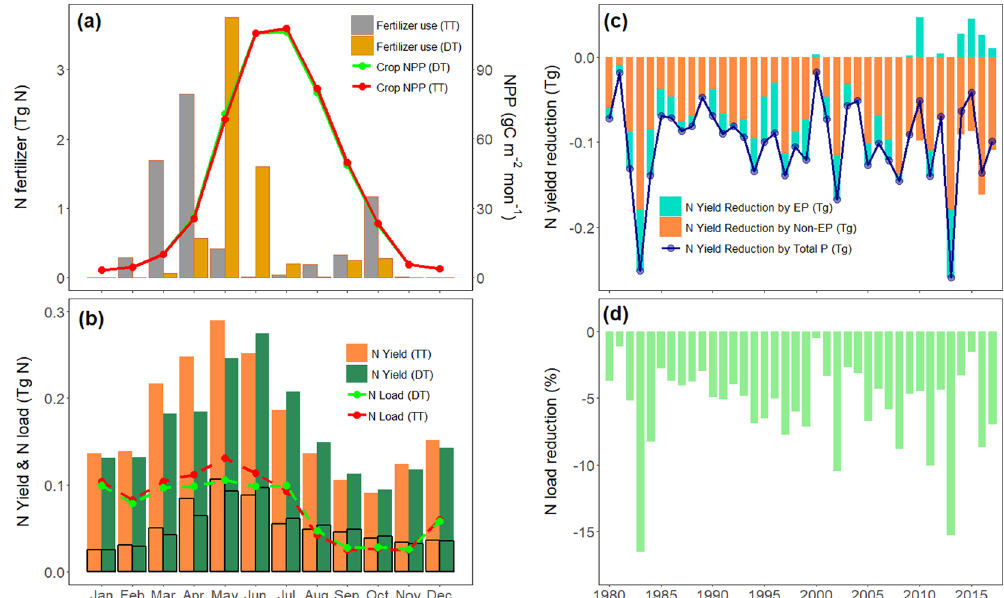
Fig. 7 The modeled effectiveness of changing N fertilizer application timing in reducing dissolved inorganic nitrogen (DIN) loads from the Basin to the Gulf. ( a ) Monthly N fertilizer use and the model-estimated crop net primary productivity (NPP) under traditional (TT) and dynamic/modi fi ed (DT) N fertilizer application timings in the Basin. ( b ) Model-estimated monthly N yield (i.e., N leaching from soils, calculated as a sum of all simulation grids) and load (i.e., N delivered to the Gulf, which is the model estimate at the outlet grid) under TT and DT N fertilizer use practices in the Basin. The black-outlined bars represent the amount of N yield that occurred during extreme precipitation days. ( c ) Nitrogen yield reduction by the dynamic fertilizer application on days with and without extreme precipitation (EP) during 1980 – 2017. The net annual reduction of N yield is represented by the dark-blue dotted line. ( d ) Model-estimated annual N load reduction at the Basin outlet to the Gulf of Mexico during 1980 – 2017 (reduction percentage is calculated as the difference in the annual N load estimates between TT and DT relative to the 1980 – 1996 baseline N load from USGS